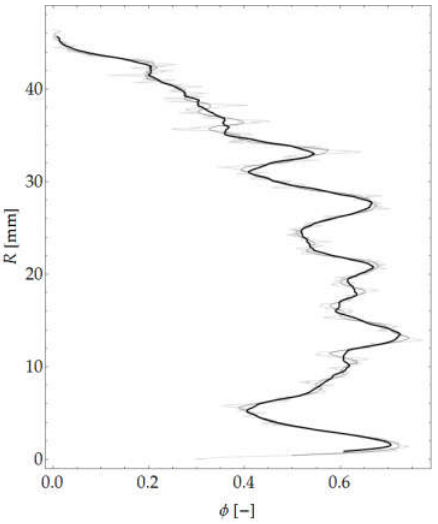
Materials 2019 , 12 , 1016 Figure 15. Aggregate content across element thickness. Figure 15. Aggregate content across element thickness.